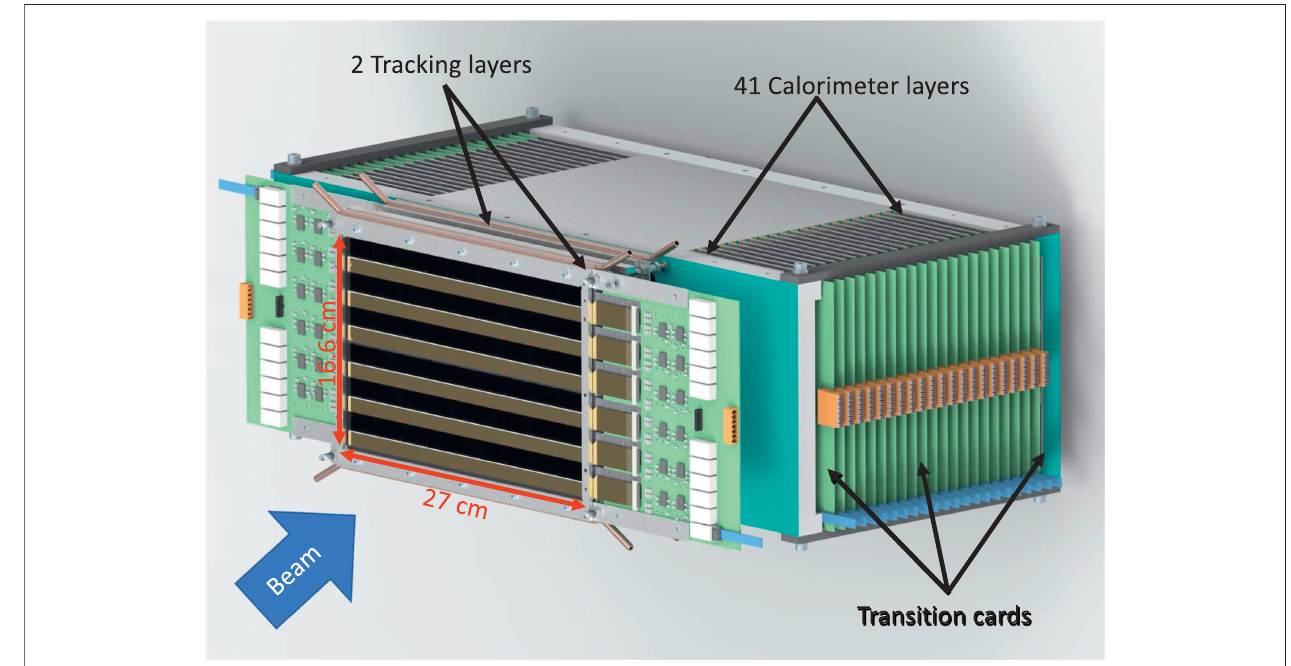
FIGURE 2 | The general structure of the Bergen pCT system. To reveal the arrangement of the sensors in the layer, the support where the ALICE pixel detector (ALPIDE) sensors will be mounted in the rear trackers is not shown.